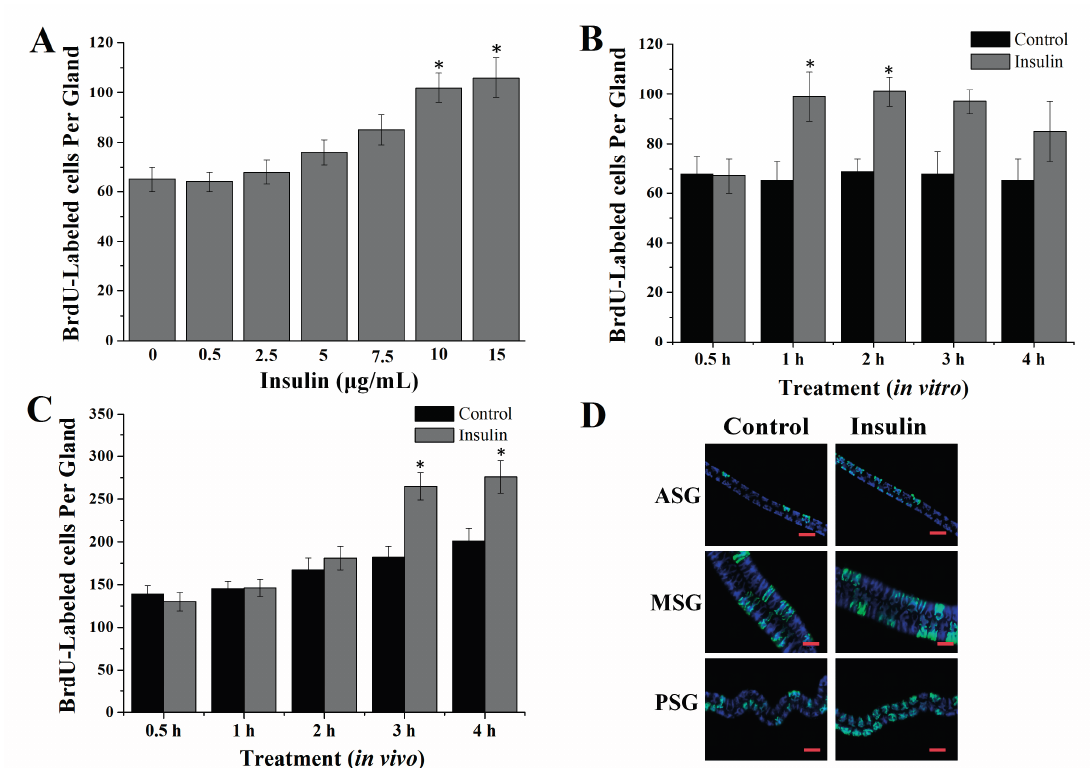
Figure 1. Effects of insulin on DNA synthesis in silk gland cells. ( A ) Concentration dependent effects in vitro ; ( B ) Time-dependent effects in vitro ; ( C ) Time-dependent effects in vivo ; ( D ) Representative images of BrdU-labeled cells in the silk gland cells at 3 h after the injection of insulin. Scale bar: 100 µm. ASG: anterior silk gland; MSG: middle silk gland; PSG: posterior silk gland. * p < 0.05.